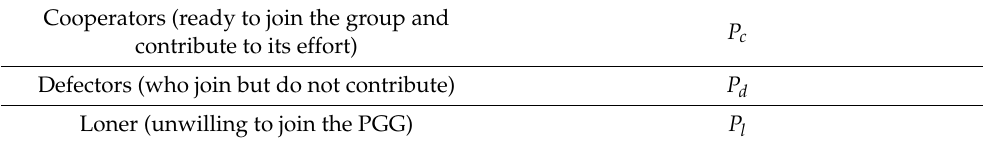
Table 1. Strategies of potential